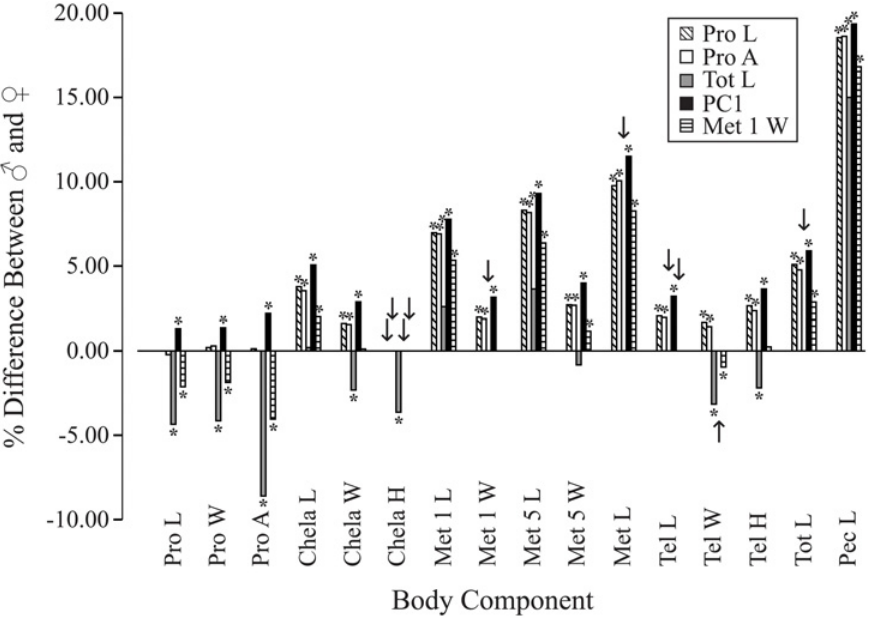
Fig 2. Sexual body component dimorphism (SBCD) in Hadrurus arizonensis , comparing the results of alternative reference characters. Analysis of covariance (ANCOVA) results are expressed as percent difference in marginal means between the sexes (y-axis) for each body component (x-axis groupings) when using different reference characters (covariates; indicated by bar pattern). Alternative reference characters included prosoma length (Pro L), prosoma area (Pro A), total length (Tot L), principal component 1 (PC1), and metasoma segment 1 width (Met 1 W). Percent difference was calculated as ((male marginal mean — female marginal mean)/((male marginal mean — female marginal mean)/2)) x 100. Thus, bars above zero indicate body components showing male-biased SBCD, and bars below zero indicate female-biased SBCD. Bars with an asterisk ( * ) indicate a significant difference between sexes. Missing bars (indicated by arrows) occur where a significant interaction between sex and the covariate (heterogeneous regression slopes) existed, precluding ANCOVA and obfuscating male-female differences. Note the incongruent interpretations of SBCD depending on which reference character is used in the ANCOVA. Additional details are provided in S1 Table.